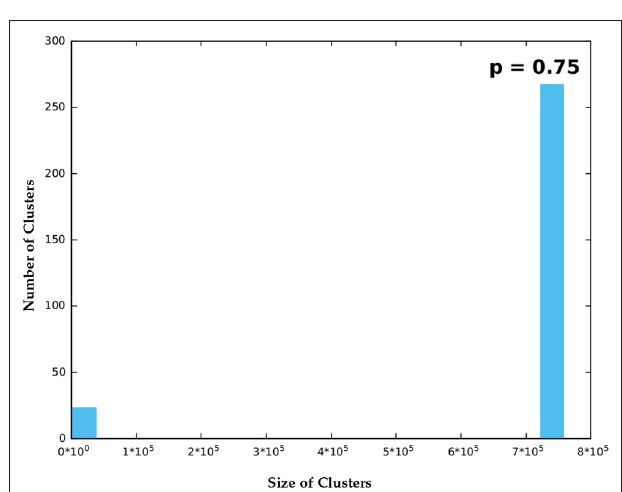
FIGURE 8 | Nearby the critical phase i.e., p = 0.5, clusters are seen to vary over a wide range and hence nearby cluster sizes were binned together to observe the averaged statistics.